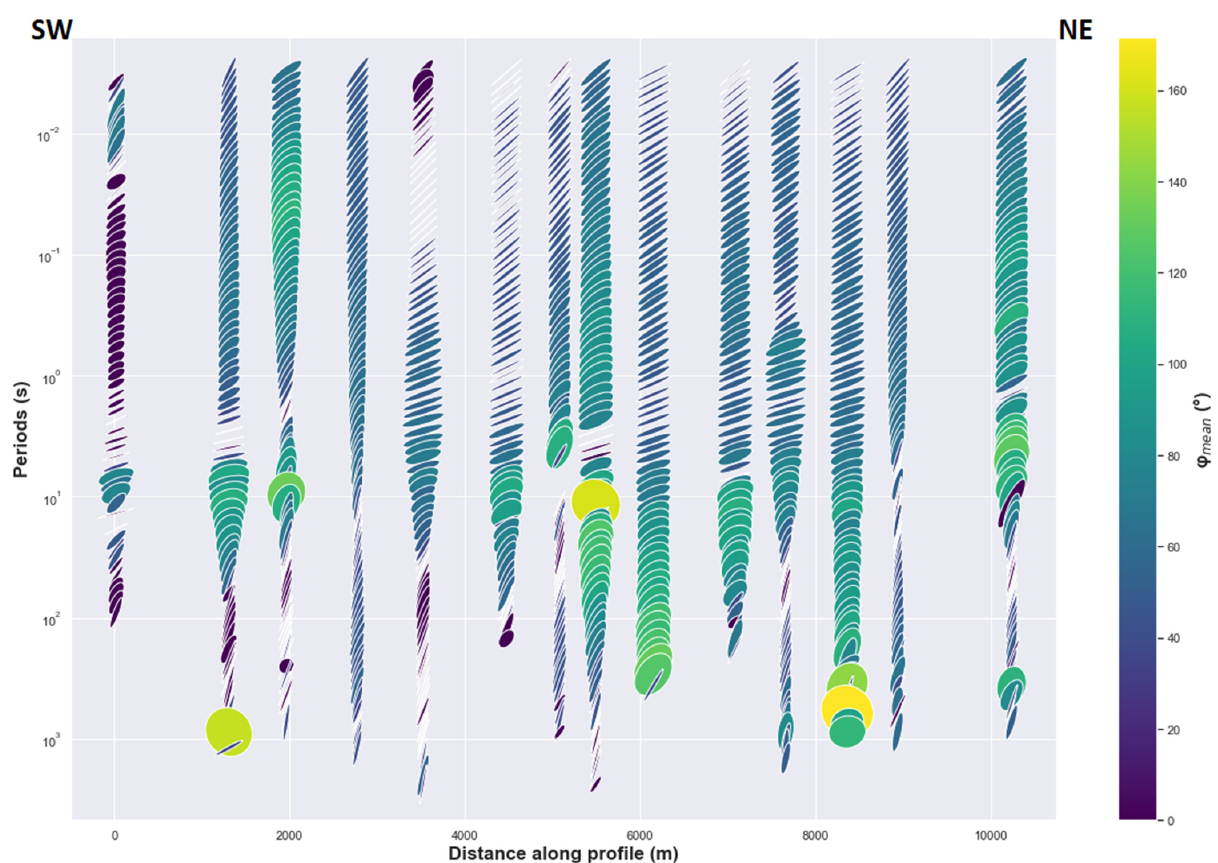
Figure 7. Pseudo-section of phases tensor ellipses along 2D profile MT sites (Figure 1).